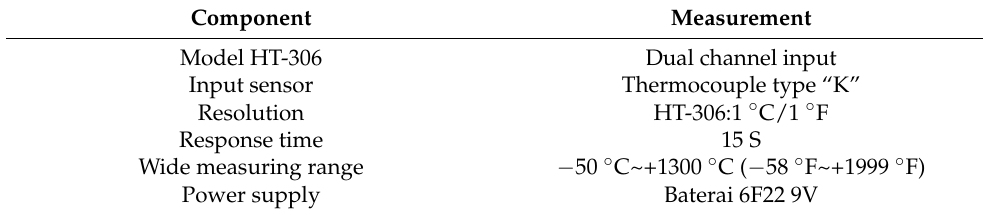
Figure 3. ( a ) Modification of hollow plate with four spoons and ( b ) digital thermometer and thermocouple for measure- ment data.